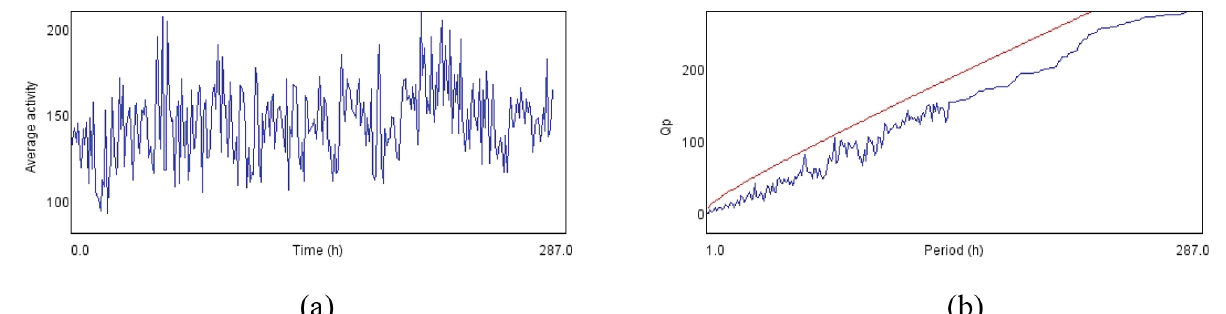
FIGURE 11S - (a) and (b) shows the average activity pattern and chi-square periodogram respectively for Control flies exposed to luteolin (75